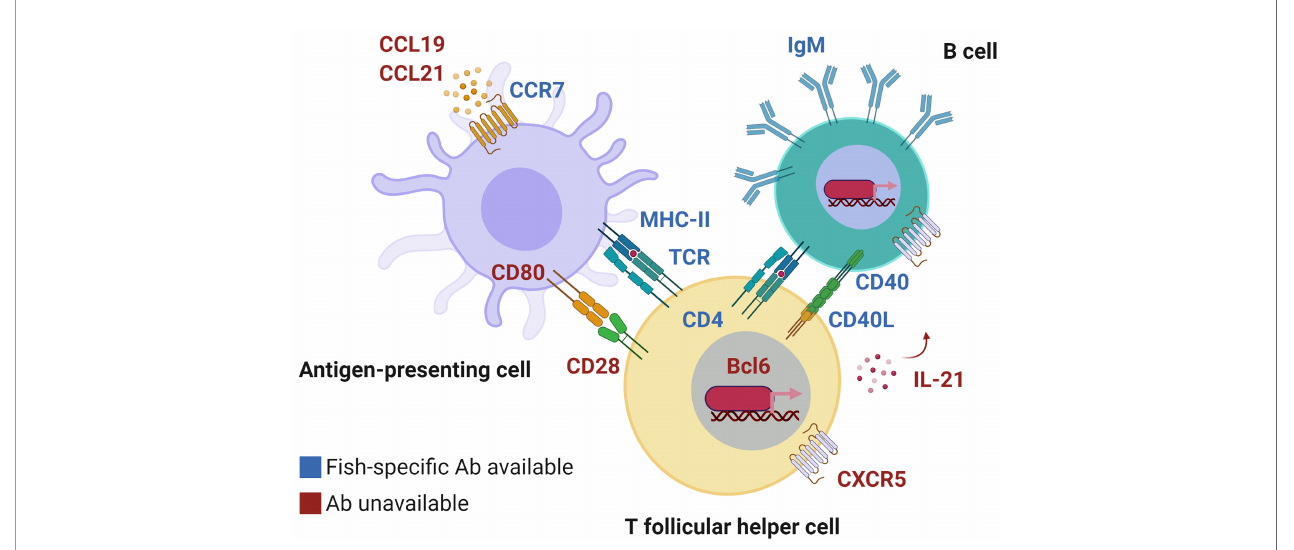
FIGURE 2 | T cells, B cells and dendritic cells interact via surface molecules to mount an adaptive immune response. These molecular interactions inform us about the “ where ” , “ when ” , and “ how ” the process takes place. In fi sh, although orthologous markers have been identi fi ed (labeled in red text), only a select few have corresponding fi sh-speci fi c antibodies that facilitate their study (in blue text) and they are not available for all species. Until we fi ll in the gaps, we will not know to what extent immune responses are mounted similarly or differently in mechanism, compared to mammals. Chemokine receptors such as CCR7 and CXCR5 ensure that pairs of antigen-presenting cells (APCs) and lymphocytes (and pairs of peptide-loaded major histocompatibility complex molecules [MHC]-T cell receptors [TCRs]) will encounter each other in specialized lymphoid niches. Co-stimulation via CD80/86 on APCs binding to CD28 on the surface of T cells, or CD40L-CD40 T cell-B cell interactions (62) lead to activation and differentiation via transcriptional regulators such as Bcl6. There is indirect evidence that immune responses are mounted in much the same way in fi sh, e.g., CD80/86 being capable of inducing cytokine production (63). However, examples such as CCR7 being predominantly expressed by B cells in trout (discovered via an anti-trout CCR7 antibody) (64) highlight the need for additional tools, and phenotyping to determine discrepancies between evolutionarily distant vertebrates. Created with